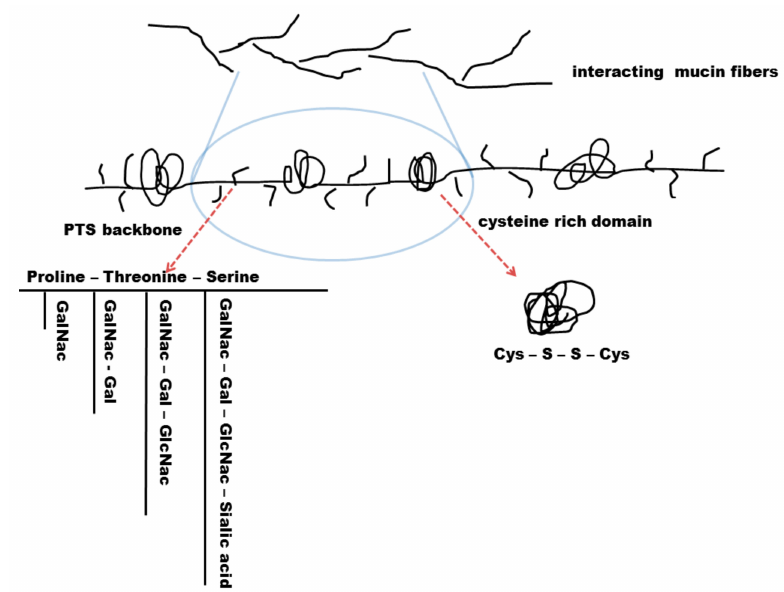
Figure 5. Secreted mucin fibres have a common scaffold consisting of a recurring PTS backbone (proline-threonine-serine) with intermitting cysteine rich domains. These domains are coiled due to their disulphide bond interactions. PTS backbones contain different amino sugar glycosylation such as N -Acetylgalactosamine (GalNac), N -Acetylgalactosamine-Galactose (GalNac-Gal) glycosylation, N -Acetylgalactosamine-Galactose- N -Acetylglucosamine (GalNac-Gal-GlcNac) glycosylation, or N - Acetylgalactosamine-Galactose- N -Acetylglucosamine-Sialic acid (GalNac-Gal-GlcNac-Sa) glycosylation. The degree of glycosylation influences mucus permeability and